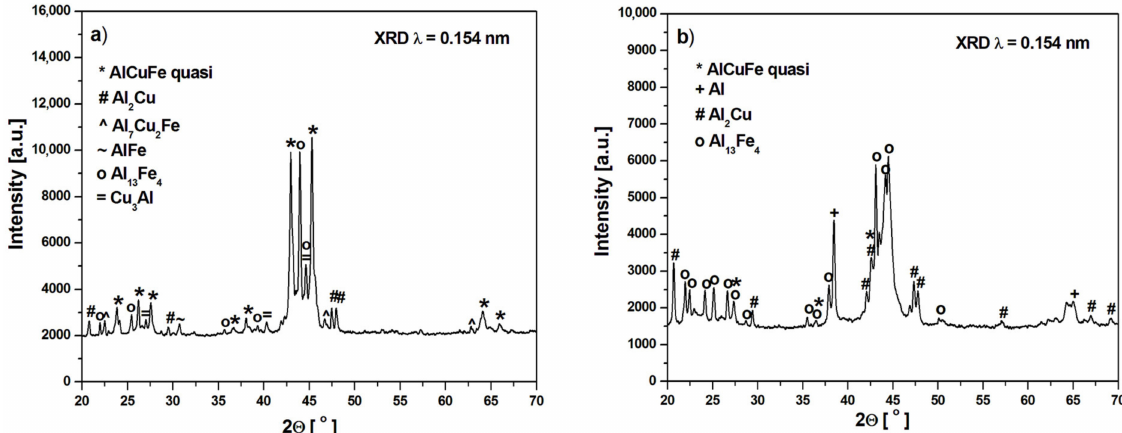
Figure 1. XRD pattern of Al 65 Cu 20 Fe 15 alloy in the form of ingot ( a ) and ribbon ( b ).